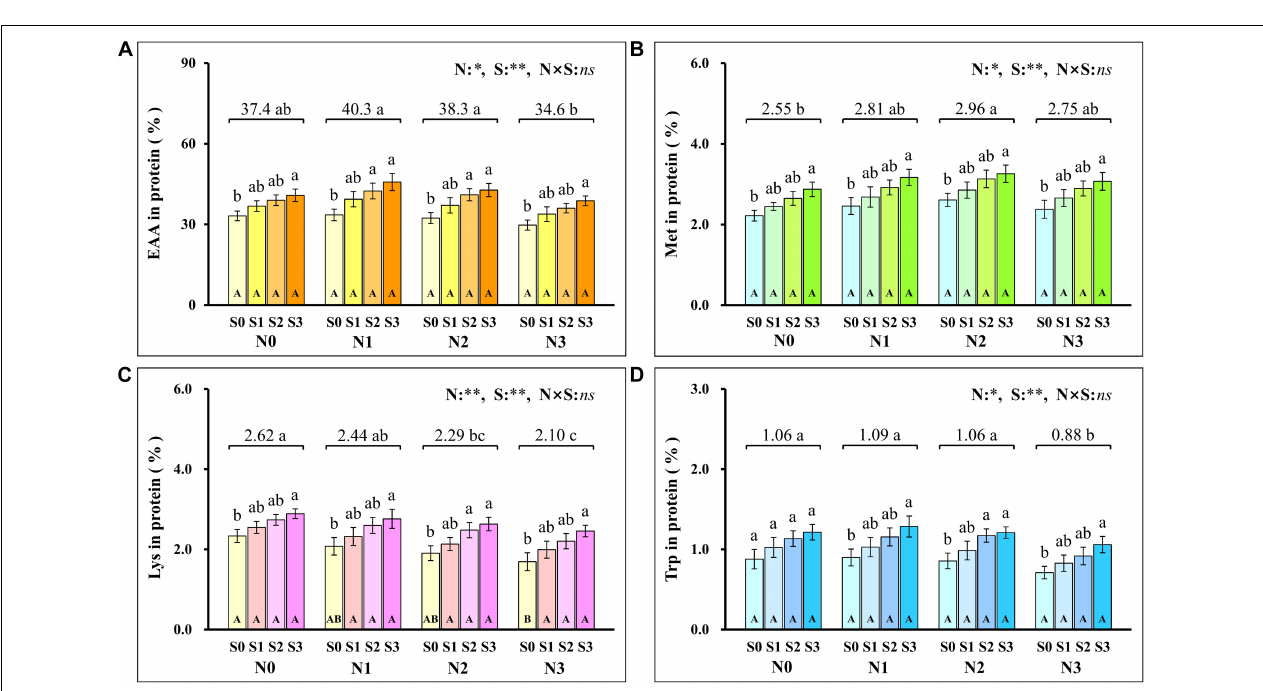
FIGURE 7 | The proportion of total essential amino acids (A) , methionine (B) , lysine (C) , tryptophan (D) in protein at different N and S rates. The data are the means of four replicates, and the error bars represent the standard deviation. The lowercase letters above the bars indicate the significant differences between the different S rates at the same N level, and the different uppercase letters in the bars indicate the significant differences between the different N rates at the same S level. The number on the horizontal line above each group of bars indicates the average value of proportion of amino acids in protein at different N levels, and the lowercase letters after the numbers indicate the significant difference in proportion of amino acids in protein at different N levels. The variance analysis used two-way ANOVA ( ∗∗ P < 0.01, ∗ P < 0.05, ns P > 0.05). EAA, total essential amino acids; Met, methionine; Lys, lysine; Trp,